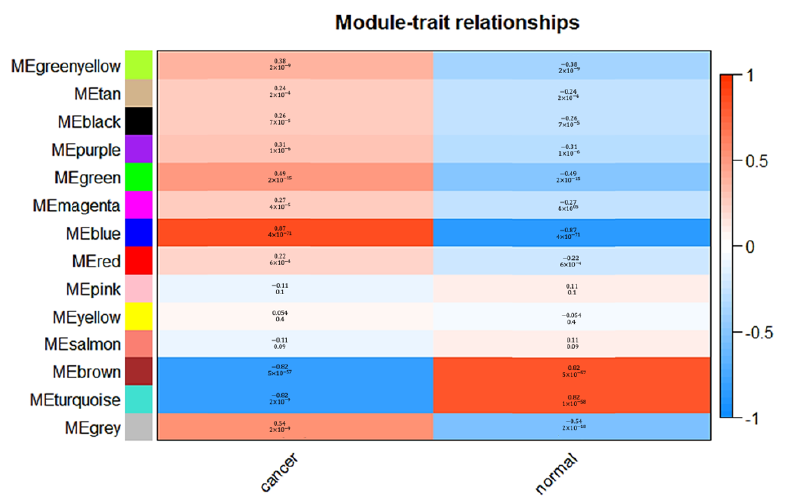
Figure 5. Correlation between modules and clinical features. (Each line contains the corresponding correlation and p -value.).